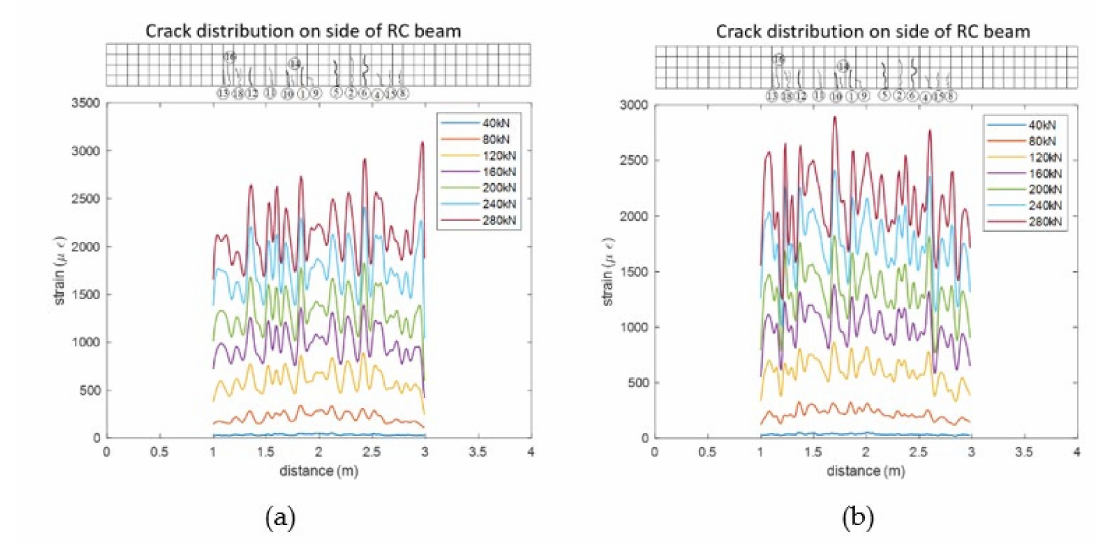
Figure 21. Strain distribution in the fibers under di ff erent load levels ( a ) fiber G4 ( b ) fiber G5.